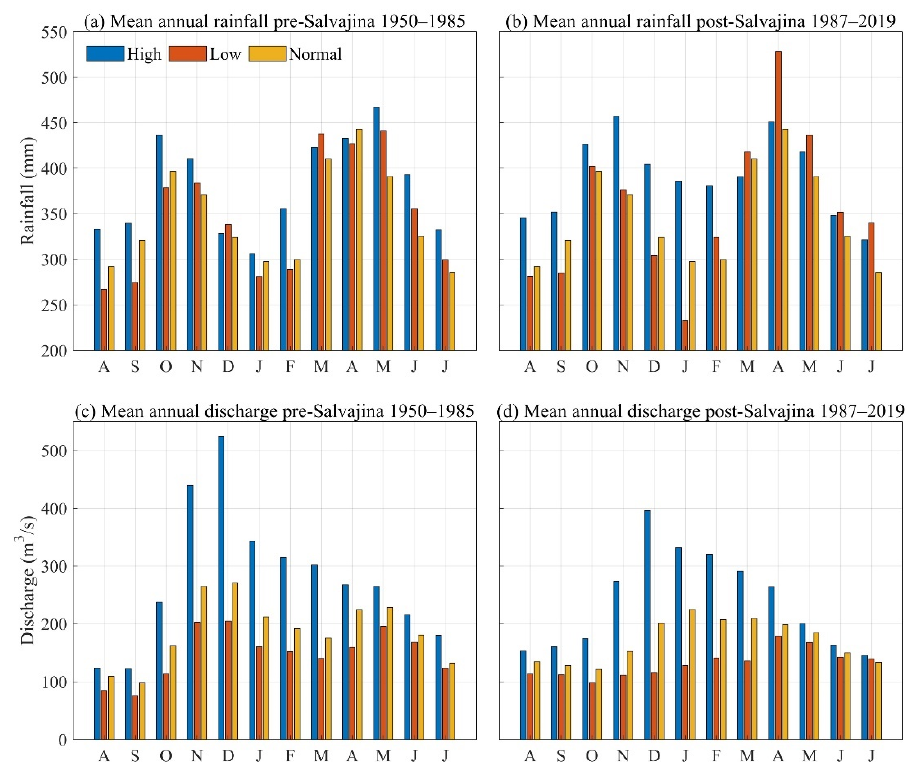
Figure 4. Annual mean precipitation cycle ( a ) before and ( b ) after the breakpoint, and annual mean discharge cycle ( c ) before and ( d ) after the breakpoint during high, low and normal discharge events. Blue bars for high discharge events, orange for low discharge events, and yellow for normal events. For precipitation the yellow bars correspond to the mean of all normal events between 1949–2019.